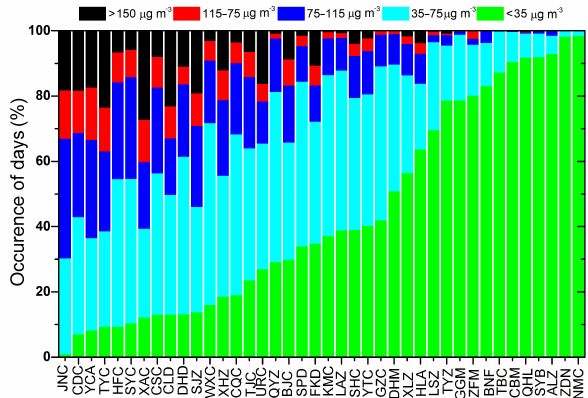
Figure 6. Days separated by the threshold values of the Ambi- ent Air Quality Standard (AAQS) (GB3095-2012) of the Chinese guidelines. The threshold values of 35, 75, 115 and 150µgm − 3 used for the daily concentration ranges are represented as clean (<35µgm − 3 ) , slightly polluted (35–75µgm − 3 ) , moderated pol- luted (75–115µgm − 3 ) , polluted (115–150µgm − 3 ) and heavily polluted (>150µgm − 3 ) , which was suggested by the AAQS guide- lines. The site codes related to the observation stations can be found in Table